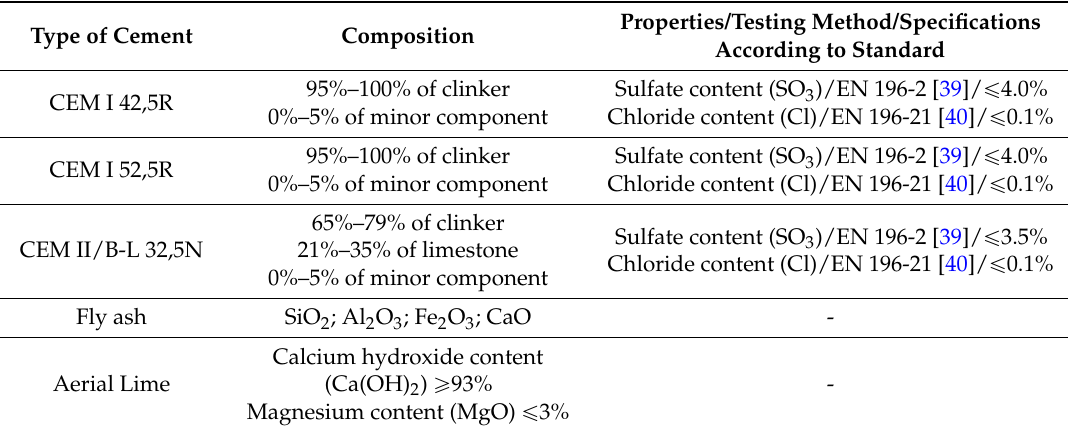
Table 2. Composition and chemical characterization of the cement.